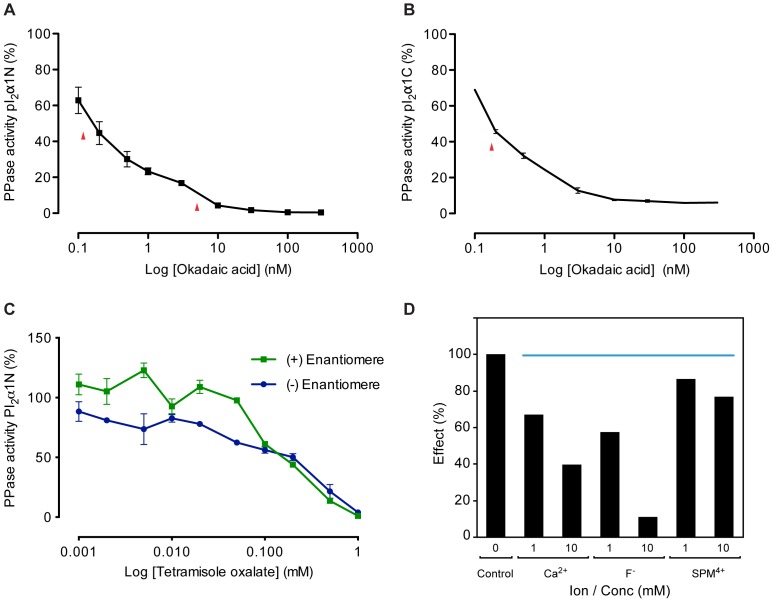
Effects of various inhibitors on the membrane-bound phosphatase activities.The phosphatase activity was performed in presence of reaction mixture contained 50 µg/ml of washed cortical membrane with 10 mM Hepes (pH 7.4) and 1 mM Mg2+, in addition to the inhibitor being tested. Incubations were performed at 30°C during 10 min. The activities are expressed as a percentage of that of control samples without inhibitors. Inhibition profiles of PPase activities by okadaic acid were performed using N-terminal phosphopeptide (A) or C-terminal phosphopeptide (B) as substrate. The data points are means ± SEM of 3 experiments. The red arrows indicate the different IC50. Using N-terminal phosphopeptide pI2α1N-P as substrate, membrane phosphatase activities were inhibited by both Br-t (+) and (−) enantiomers with close IC50 values of 0.2 and 0.1 mM respectively (C), thus excluding alkaline phosphatase. Data points are the average ± SEM of duplicate assays. (D) Effect of Ca2+ ions, fluoride (F−) and spermine (SPM4+) on PPase activity using N-terminal phosphopeptide as substrate.